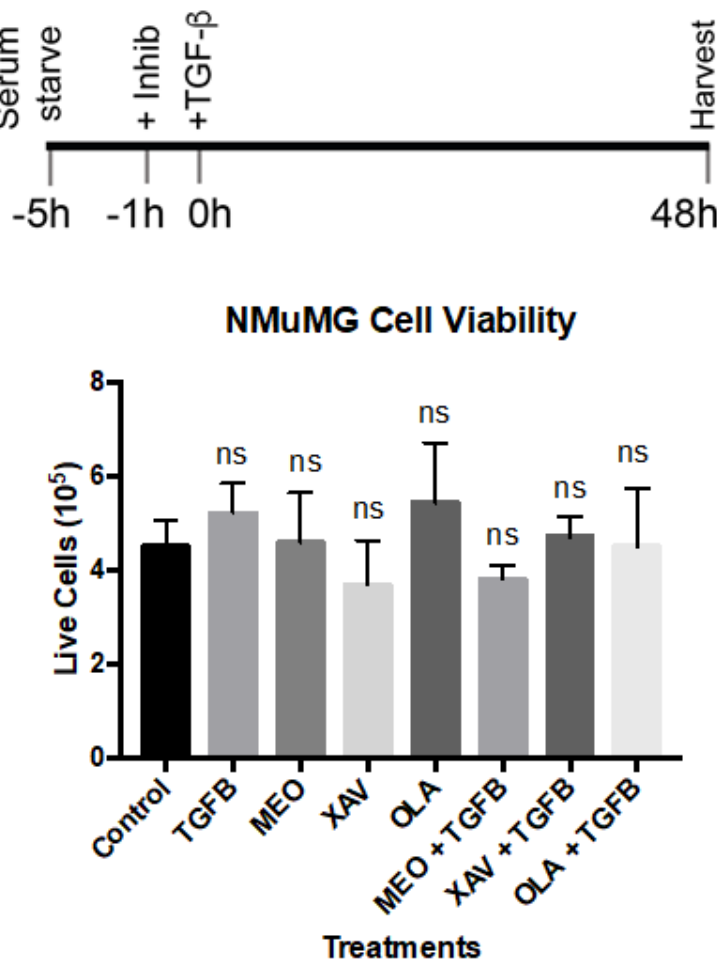
Figure A3. All the inhibitors were used at a 10 µ M concentration using the same schedule as in Figure 3A. The cells were trypsinized, stained with Trypan Blue, and counted using the Invitrogen Countess cell counter, which distinguishes live and dead cells. The cells are plotted as a total number of live cells ( × 10 5 ) for each treatment. The experiment was repeated in triplicate and the GraphPad Prism was used to perform an unpaired t-test represented as SEM relative to the control treated cells. There is no significant effect on cell viability.